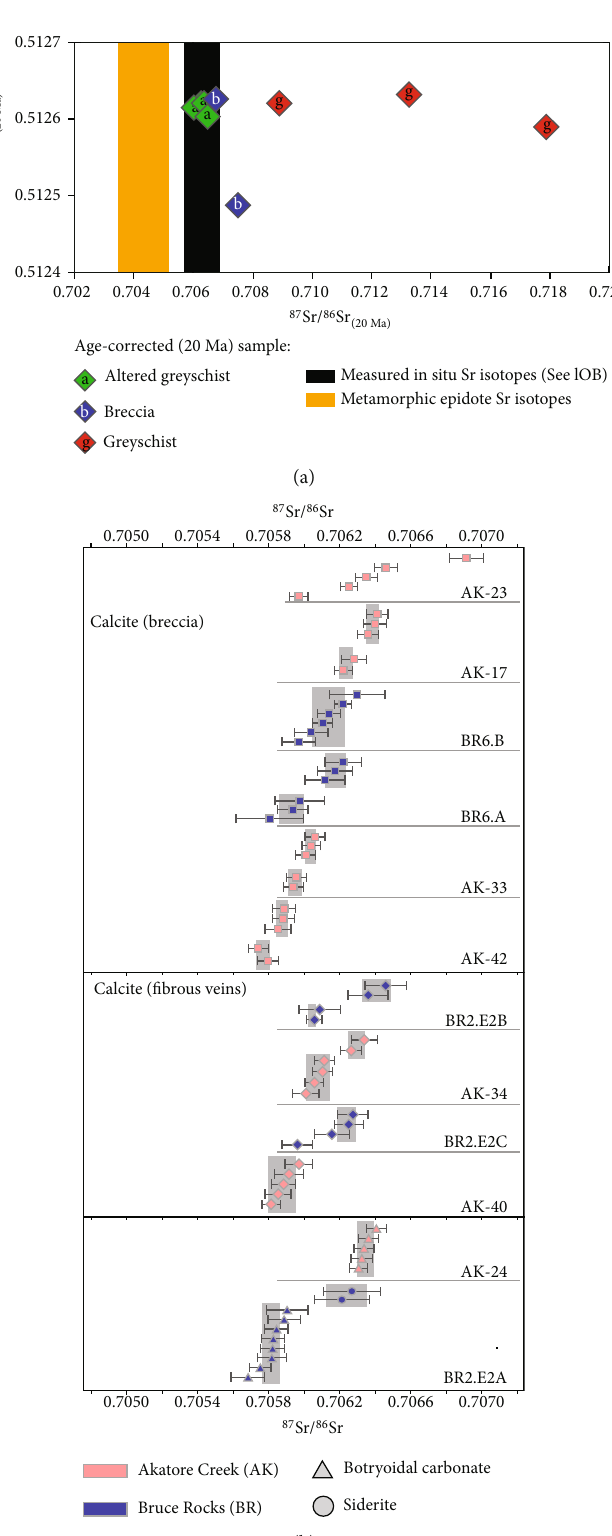
Figure 8: Strontium and neodymium isotopes. (a) Measured in situ 87 Sr/ 86 Sr of carbonate phases (the grey area, see (b) for data) compared to age-corrected (20 Ma) measured whole-rock 87 Sr/ 86 Sr and 143 Nd/ 144 Nd from the greyschist, altered greyschist, and hydrothermal breccia. Published in-situ 87 Sr/ 86 Sr for epidote are plotted for comparison [11, 24]. (b) Individual in situ 87 Sr/ 86 Sr isotope data of the di ff erent types of carbonate phases from Akatore Creek and Bruce Rocks. The grey boxes represent the weighted average Sr isotope ratio with errors from each group of